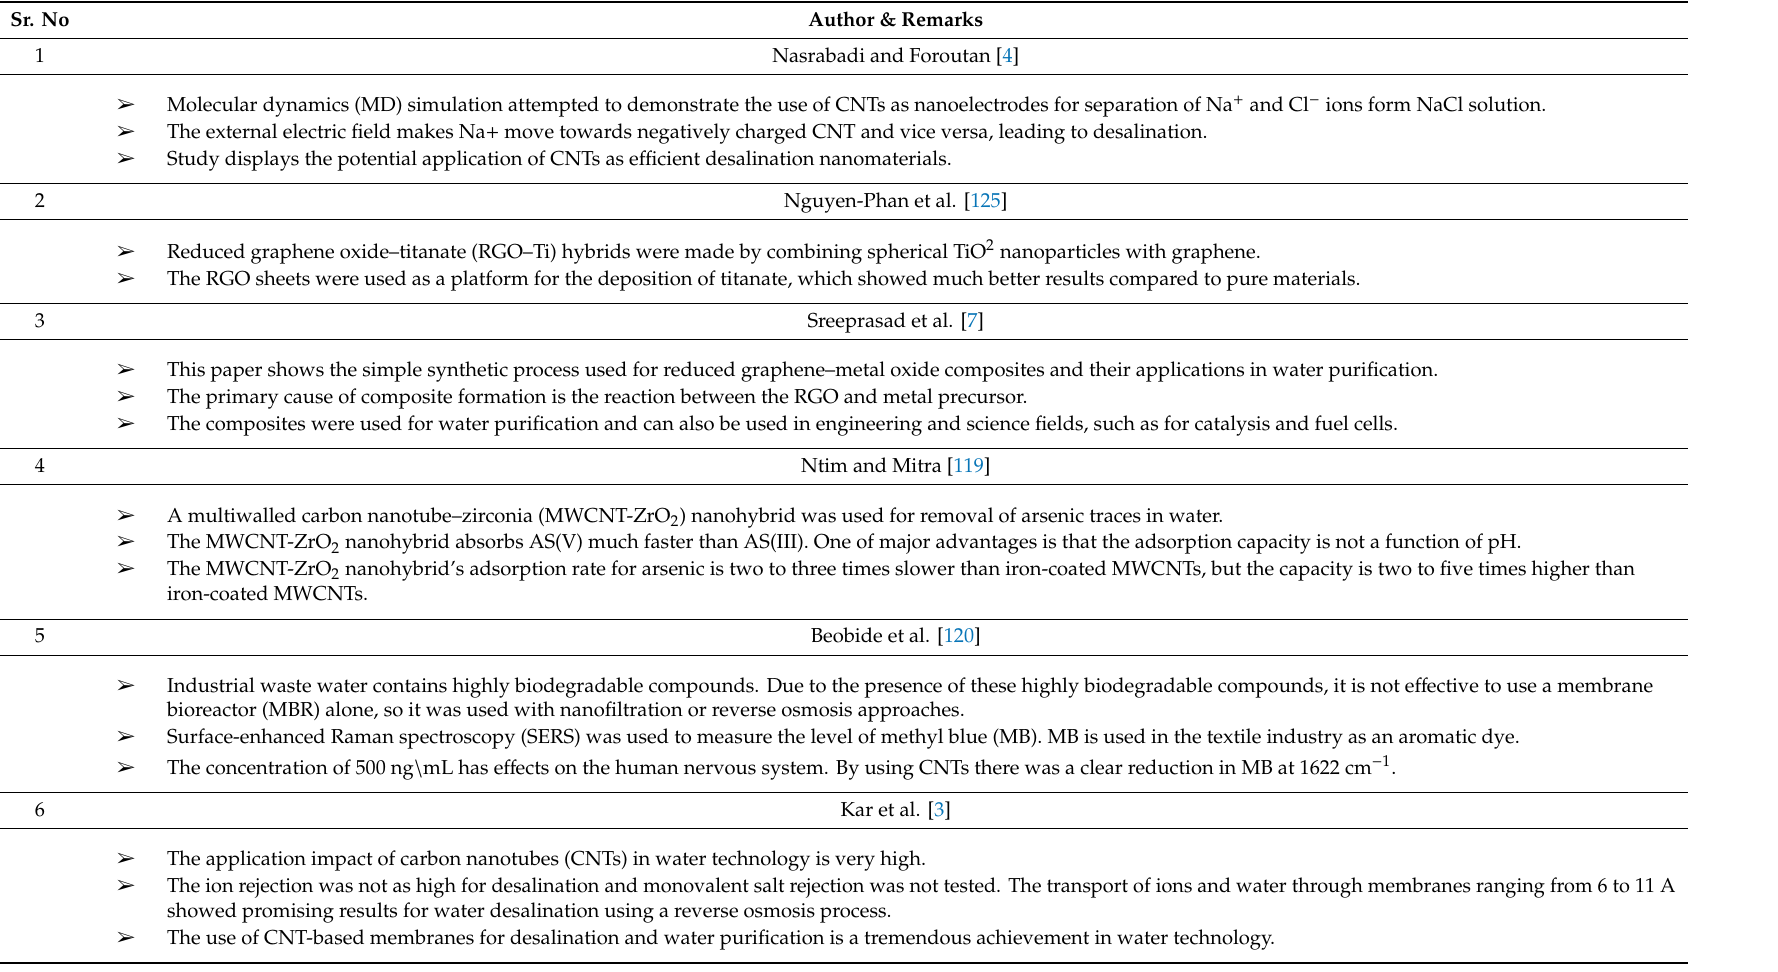
Table 2. Studies on water